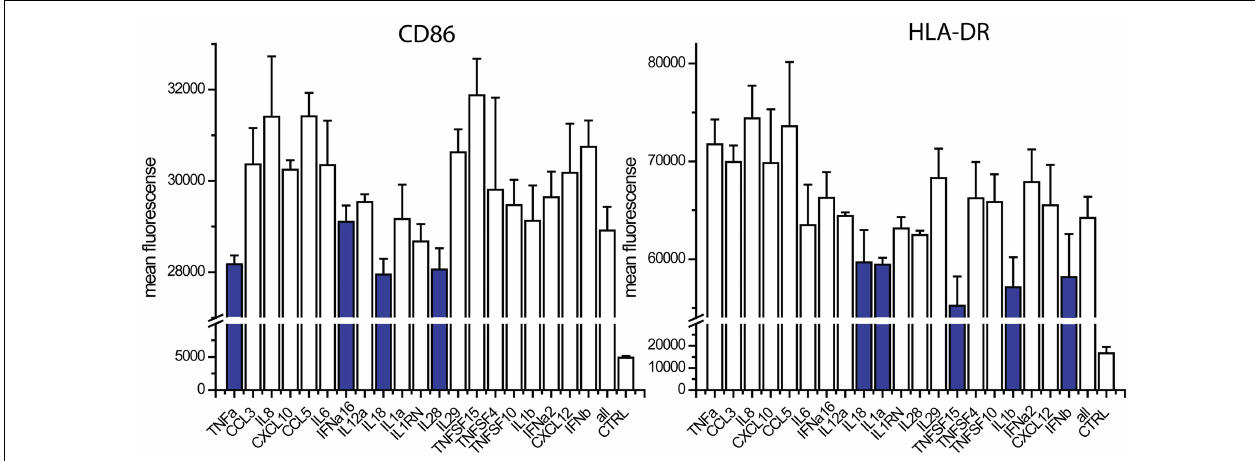
FIGURE 4 | Contribution of individual cytokines in 20 cytokine paracrine signal . Maturation marker expression of DCs after 8h to exposure to all 20 cytokines (all) or the leave-one-out combinations of 19 cytokines. Note that a reduction in expression with a cytokine absent indicates that the cytokine may contribute to induction.